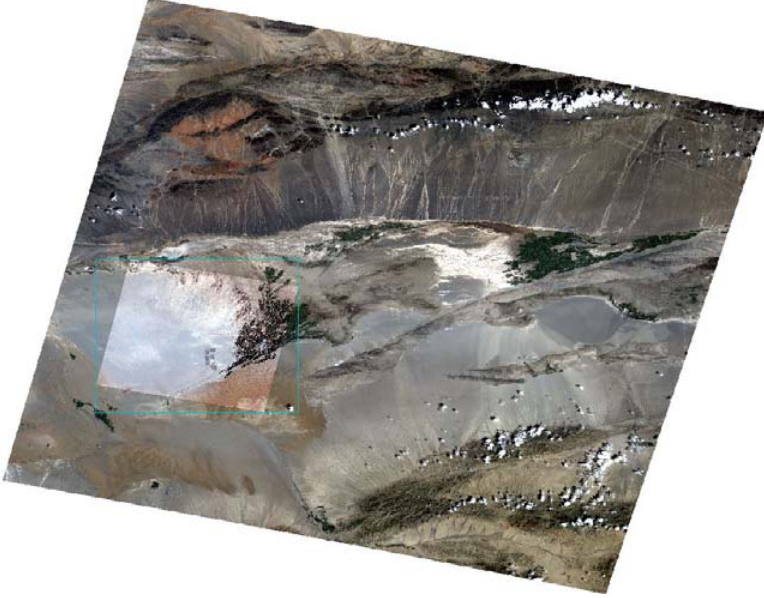
Figure 14. The Dunhuang test site in Landsat-8 OLI and ZY3-02 MUX imagery. The Dunhuang test site was used for cross-validation based on the stability and homogeneity of the Gobi Desert (Figure 15).